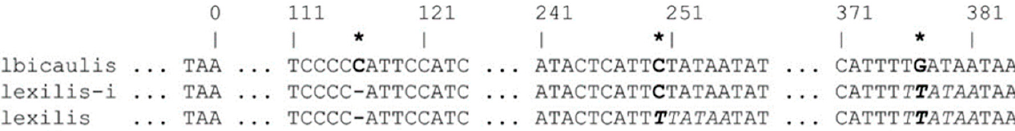
Figure 3. Three chloroplast psbA - trnH spacer haplotypes detected in this study. The numbers across the top represent nucleotide site positions beginning after the TAA stop codon in the 5’ flanking psbA gene. Asterisks and bold font indicate site numbers 116, 250, and 377, where differences in nucleotides mark each haplotype. Nucleotides in italic mark the PsiI restriction sites (250–255, 376–381), which are found in the two haplotypes sampled from limber pine but not in the single haplotype sampled from whitebark pine. The PsiI restriction site encompassing sites 250–255 is unique to limber pine (Supplemental Figure S1, panel B).